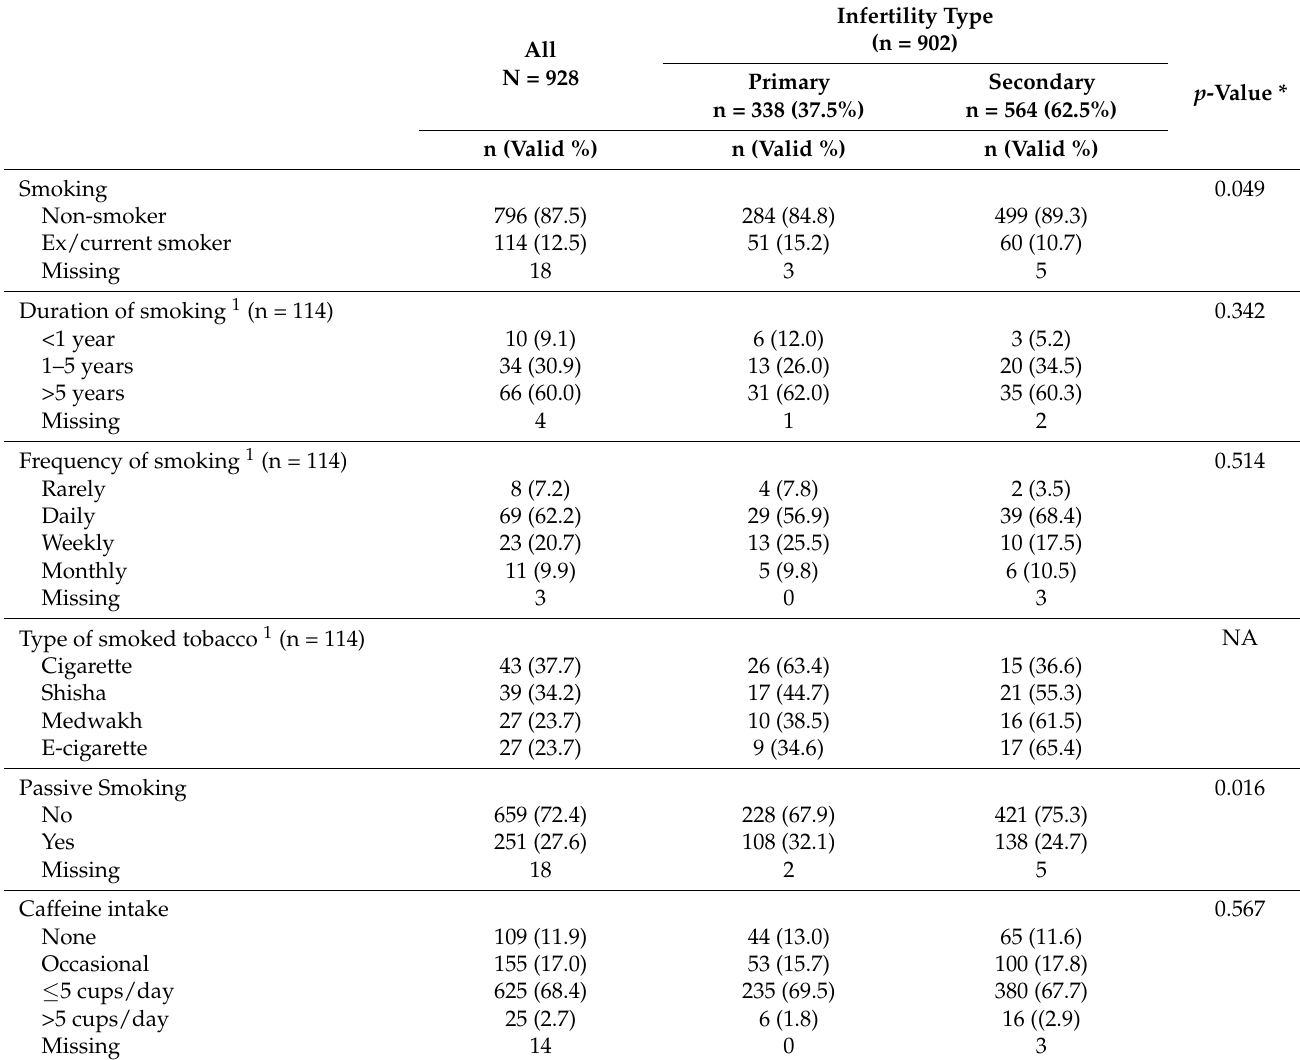
Table 2. Lifestyle characteristics of fertility clinic attendees, and the distribution between primary and secondary infertility.